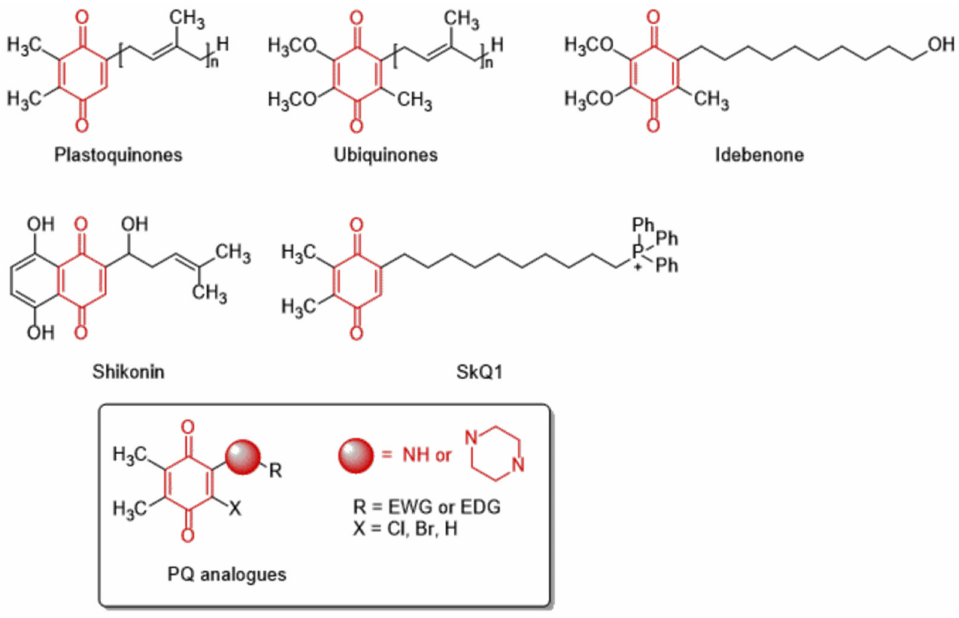
Figure 1. The structures of natural and synthesized substances containing 1,4-quinone moiety.